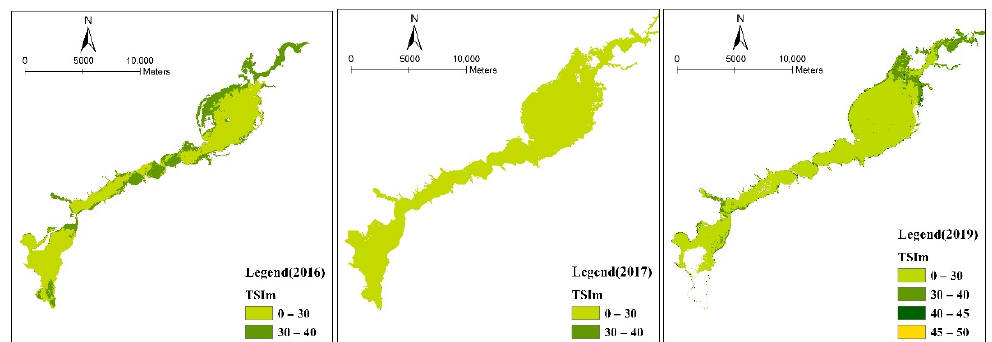
Figure 6. Nutritional status of the Guanting Reservoir. The nutritional index values were mainly concentrated at 0–30, indicating a state of poor nutrition.